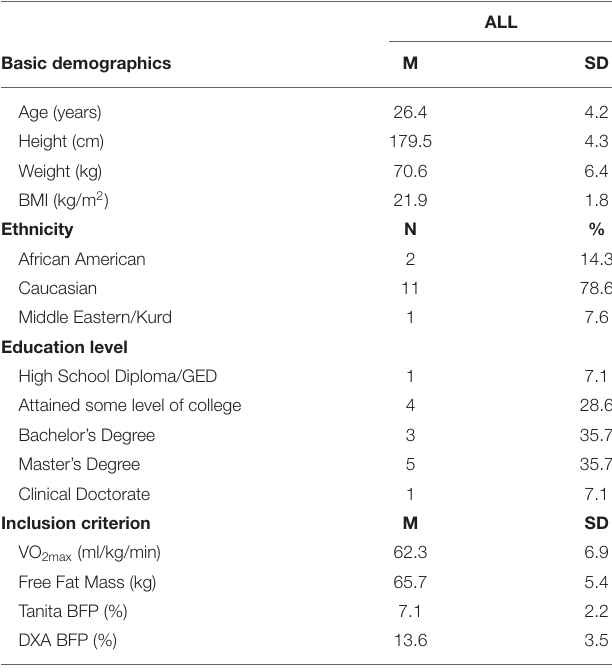
TABLE 2 | Energy needs assessment and male athlete triad components for endurance-trained male athletes ( n = 14). Energy needs